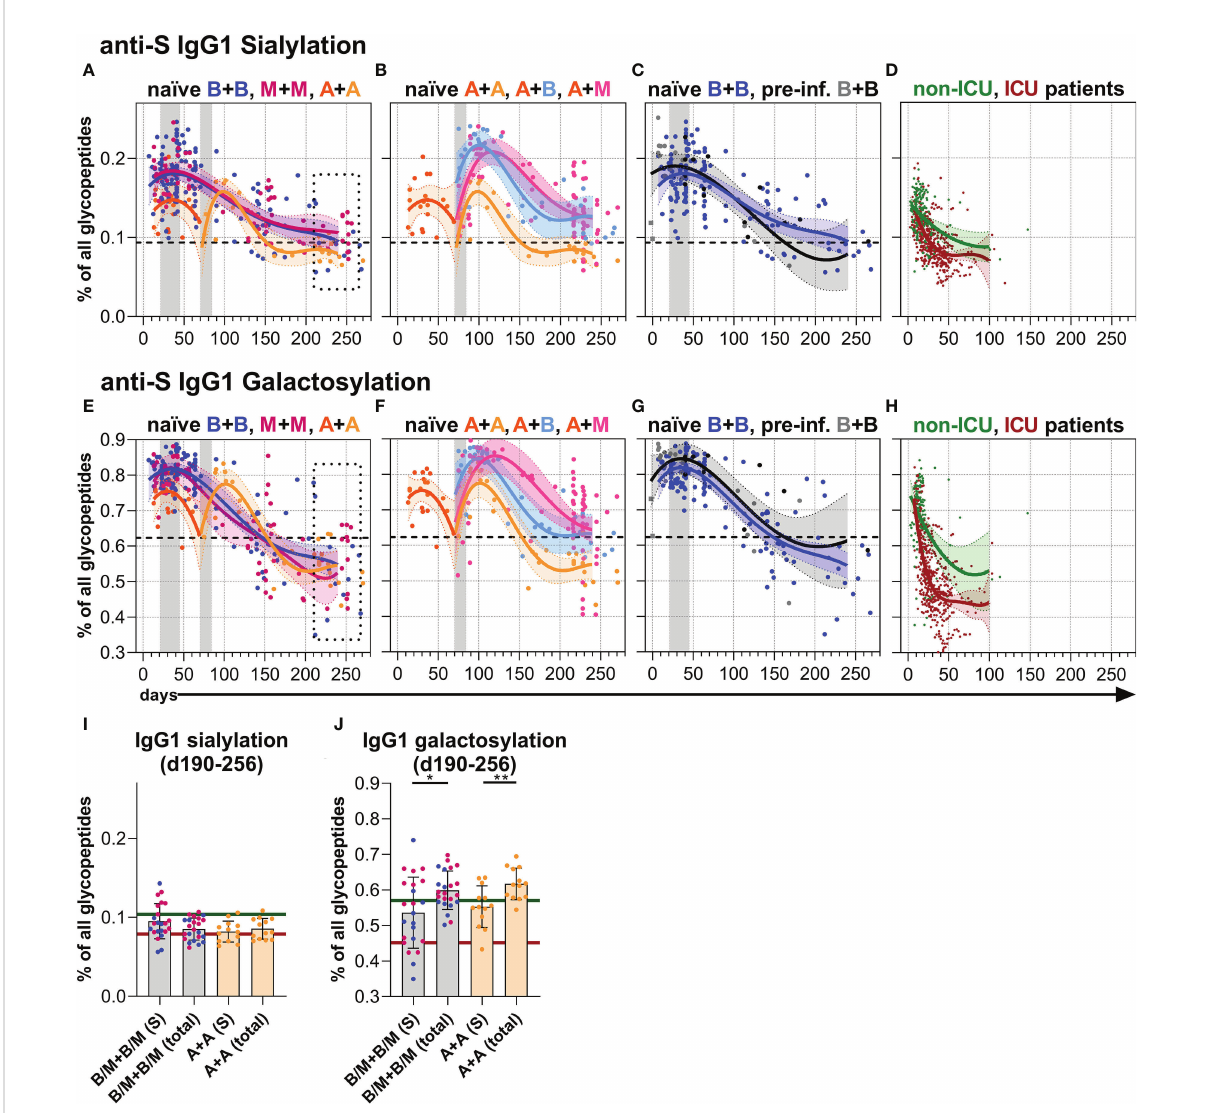
FIGURE 5 Anti-S serum IgG1 sialylation and galactosylation. (A – C) Anti-S serum IgG1 Fc N -sialylation and (E – G) anti-S serum IgG1 Fc N -galactosylation of the indicated six vaccination groups. The used color codes are identical to Figure 1D. Gray bars: time windows of the second shot after the fi rst shot with an mRNA (between day 21 and 45) or adenovirus-based (between day 70 and 84) vaccine. Dashed lines indicate the average level of total IgG1 Fc sialylation and galactosylation, respectively (Figure S6). (D) Anti-S serum IgG1 Fc N -sialylation and (H) anti-S serum IgG1 Fc N - galactosylation of unvaccinated, hospitalized non-ICU and ICU SARS-CoV-2 patients from our previous study (60) for comparison. (I, J) Comparison of anti-S and total (Figure S6) IgG1 (I) sialylation and (J) galactosylation levels of samples from mRNA (B/M+B/M; B: blue; M: pink) or adenovirus (A+A) vaccinated individuals collected late between day (d) 190 and 256 upon fi rst immunization. The green and red lines indicate the mean of the anti-S IgG1 sialylation and galactosylation levels from the hospitalized non-ICU and ICU patients, respectively, upon day 50 post-infection (D, H)